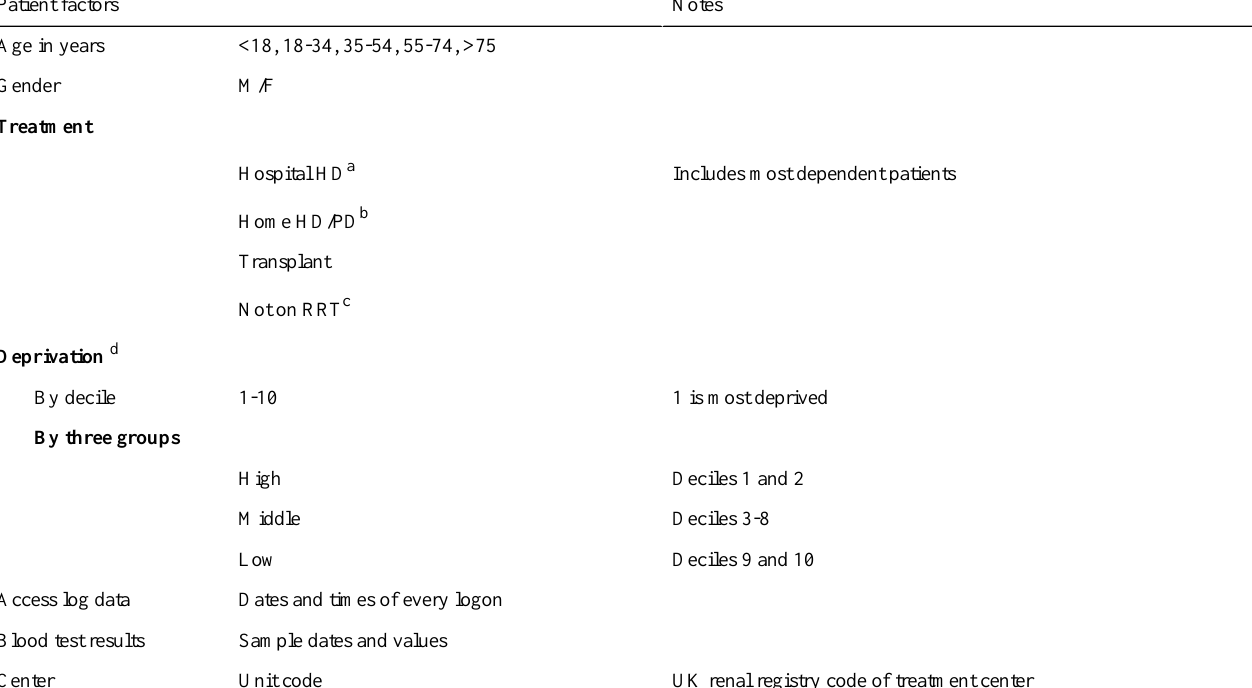
Table 1. Patient